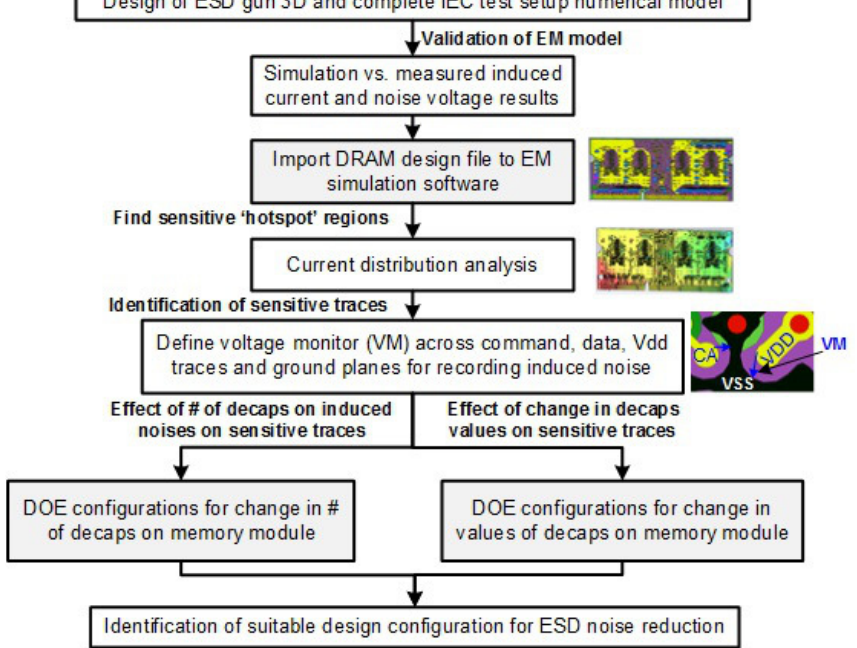
Figure 1. Proposed system level ESD coupling analysis framework based on